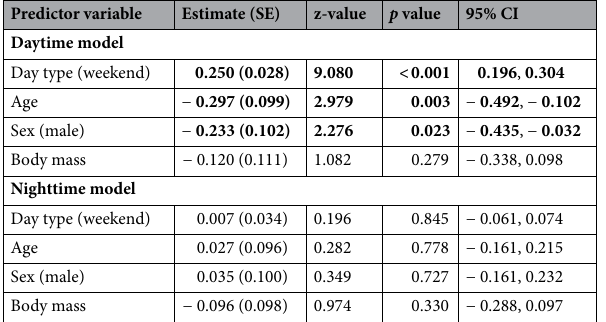
Table 1. Summary of conditional model-averaged coefficients from LMM evaluating the effects of day type, age, sex, and body mass on daytime and nighttime activity. Significant effects ( p < 0.05) are bolded.